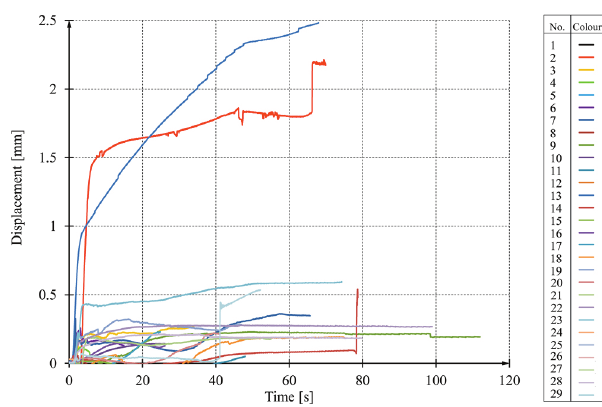
Fig. 21b. Slip in pile free end plane in concrete specimens